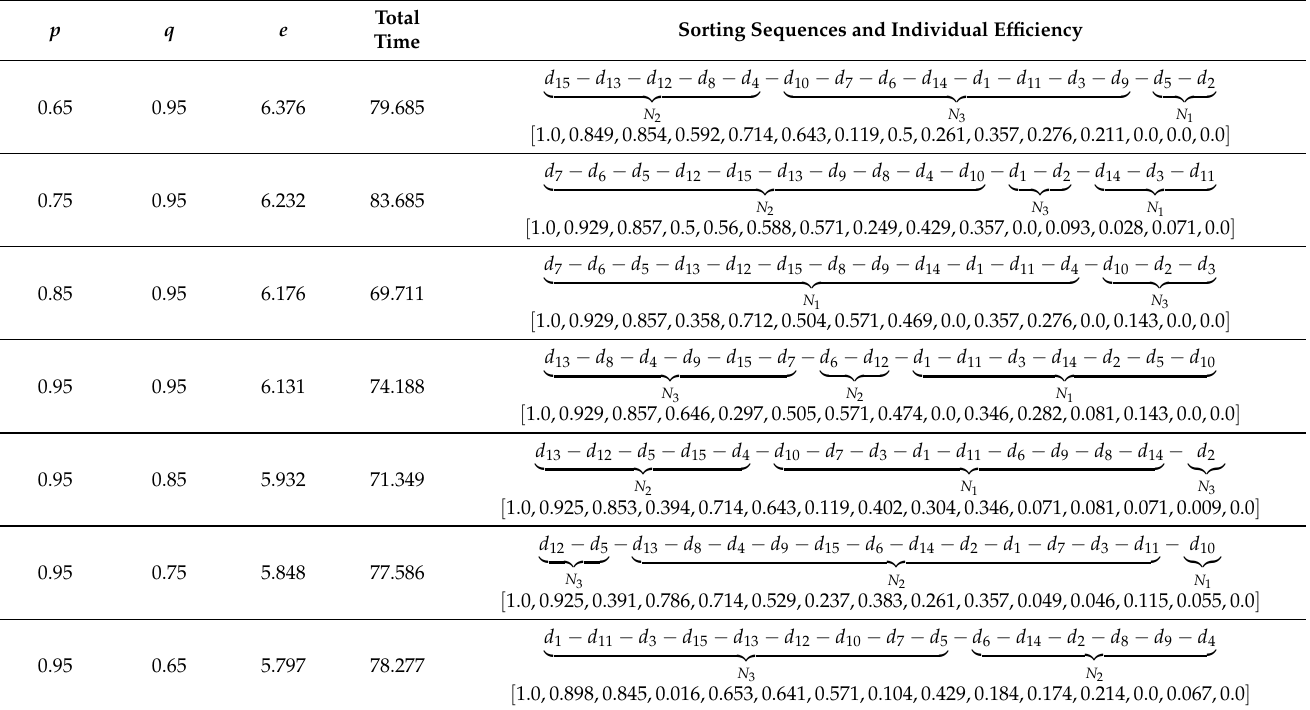
Table A2. Solutions of sorted negotiation model with different p , q ( o (cid:48) ∼ U ( 10,210 ) , B 0 = 4100, T = 85). Sorting Sequences and Individual